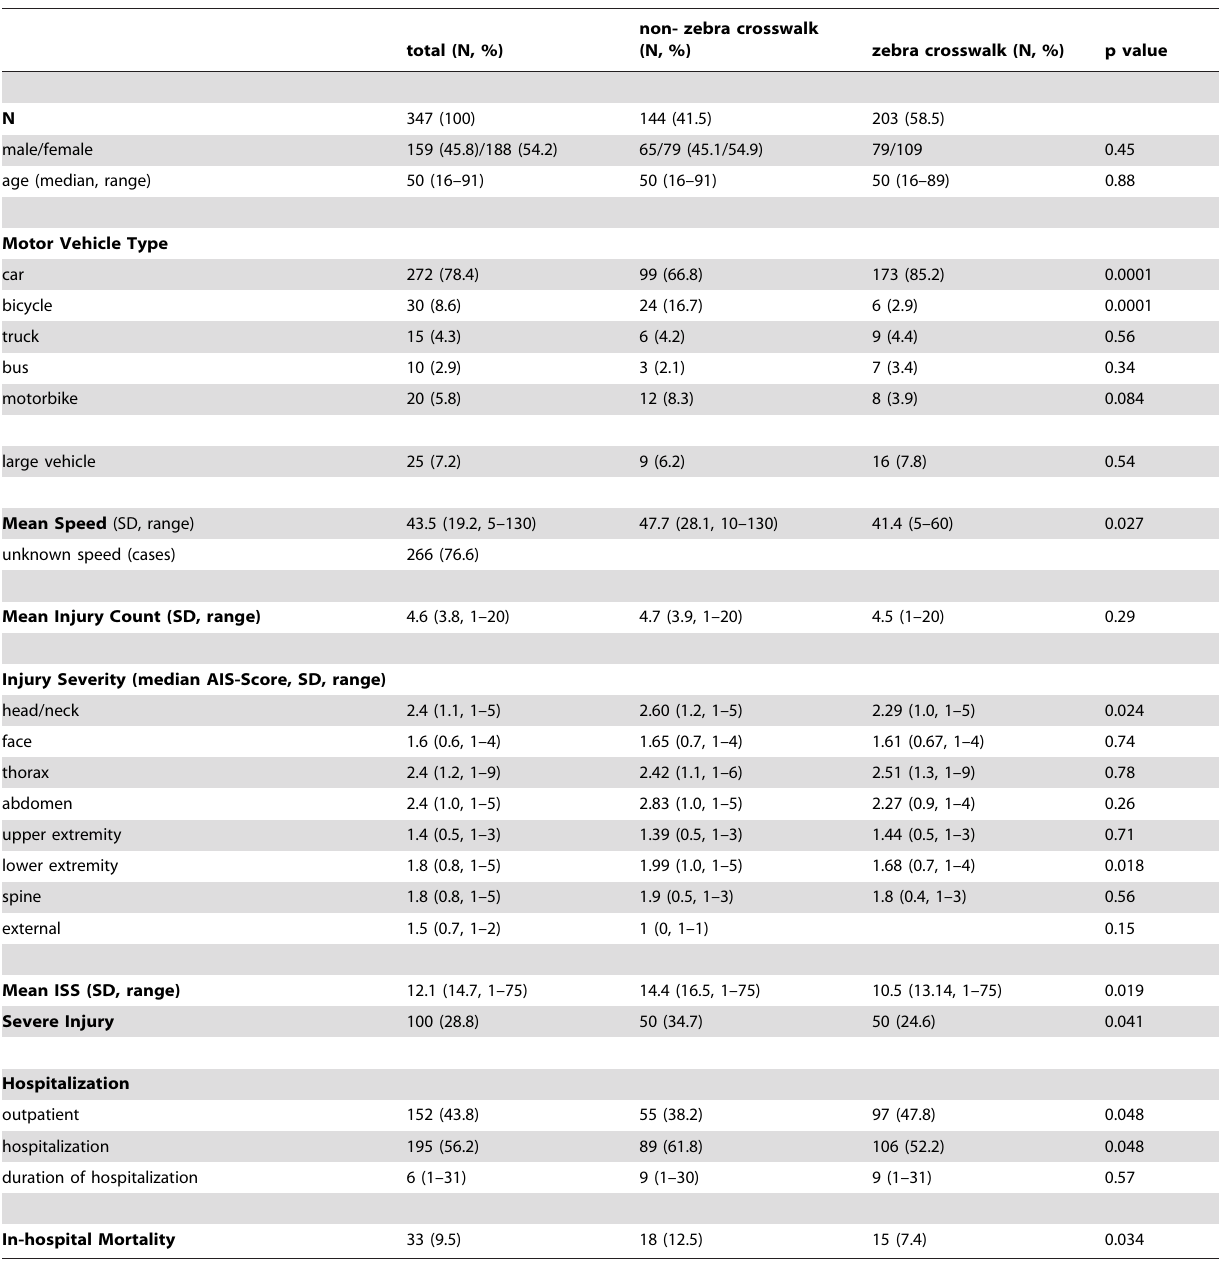
Table 1. Patient Characteristics.